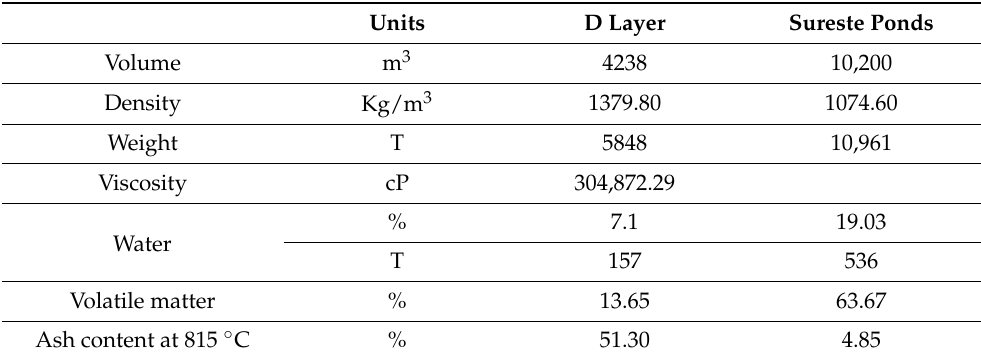
Table 1. Characteristics of the contaminant material of the settling